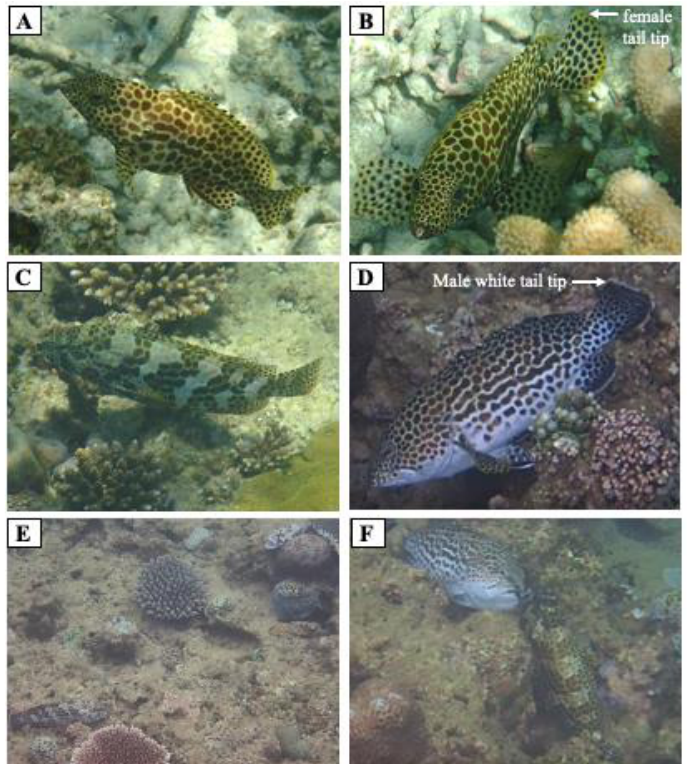
Figure 2. Body shape and color patterns exhibited by both sexes of honeycomb grouper during the daytime in the spawning ground. Females showed swollen abdomens with a normal honeycomb-dot color pattern ( A , B ). Males and females also exhibited a striped pattern ( C ). Males showed a white belly and white tail-tip ( D ). The striped pattern was observed in males when they exhibited aggressive behavior toward other males ( E ). The striped pattern was observed in females during male–female interactions, while males showed a white belly with an eye bar during male–female interactions ( F ).